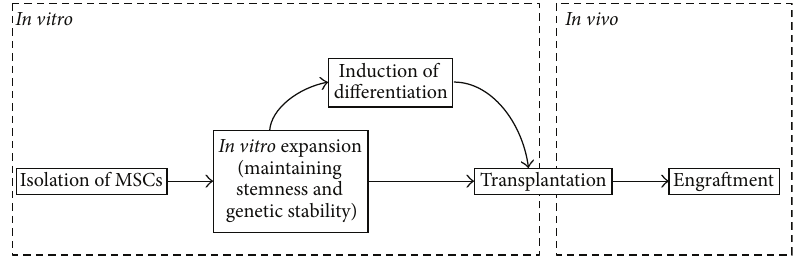
Figure 1: Steps involved in MSCs-based